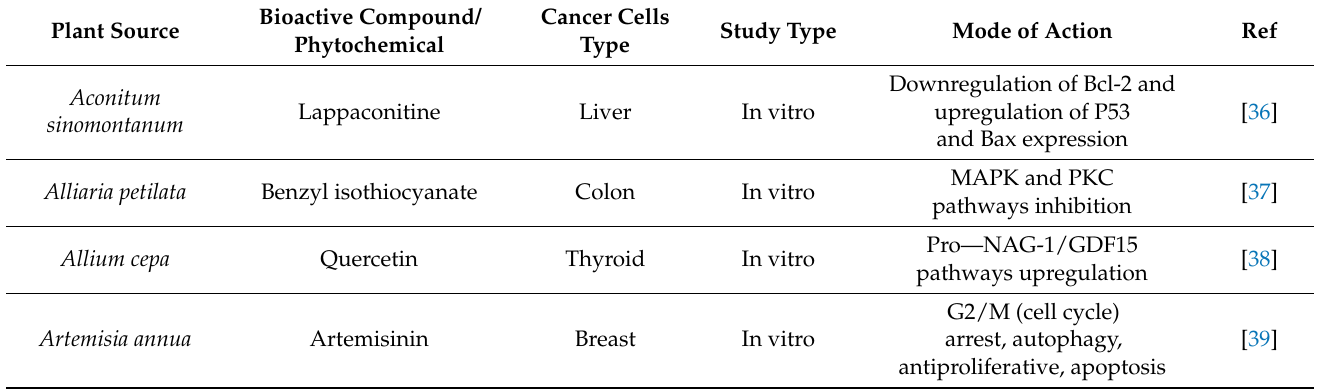
Table 1. Plant-derived bioactive compounds as anti-cancerous agents along with their modes of